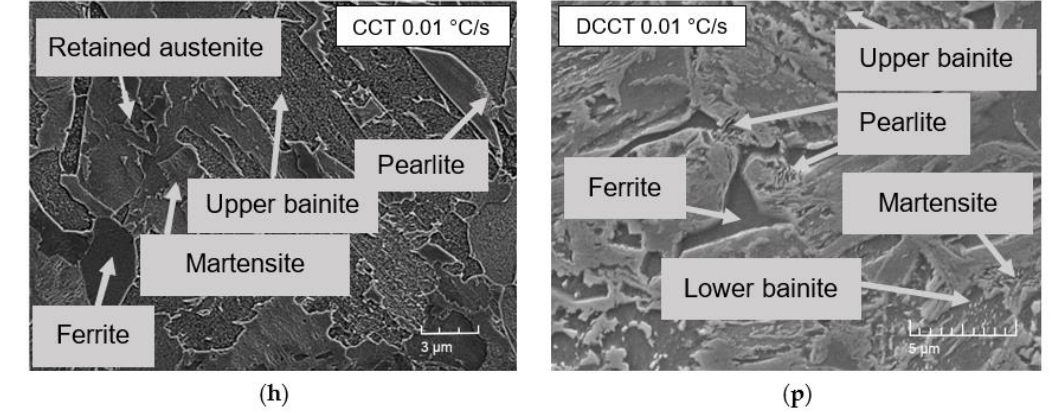
Figure 9. Comparison of SEM micrographs: ( a ) CCT 100 ◦ C/s, ( b ) CCT 10 ◦ C/, ( c ) CCT 5 ◦ C/s, ( d ) CCT 1 ◦ C/s, ( e ) CCT 0.5 ◦ C/s, ( f ) CCT 0.1 ◦ C/, ( g ) CCT 0.05 ◦ C/s, ( h ) CCT 0.01 ◦ C/s, ( i ) DCCT 100 ◦ C/s, ( j ) DCCT 10 ◦ C/, ( k ) DCCT 5 ◦ C/s, ( l ) DCCT 1 ◦ C/s, ( m ) DCCT 0.5 ◦ C/s, ( n ) DCCT 0.1 ◦ C/s, ( o ) DCCT 0.05 ◦ C/s, ( p ) DCCT 0.01 ◦